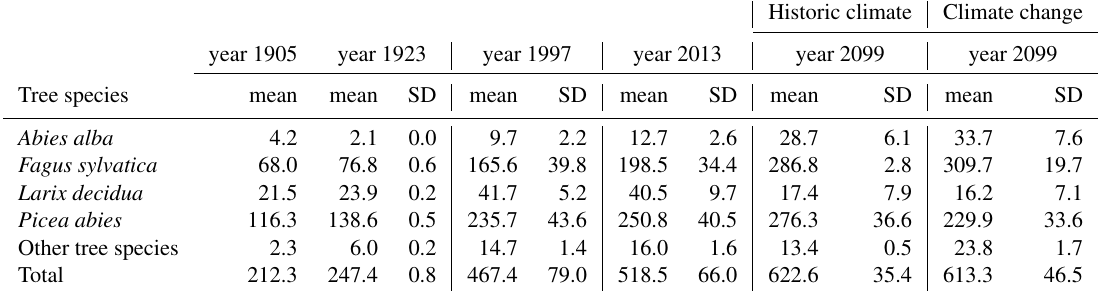
Table 2. Growing stock by tree species (m 3 ha − 1 ). Values are based on iLand simulation runs and indicate species means and standard deviation (SD) over averaged landscape values of the replicates in the respective scenarios. “Historic climate” assumes the continuation of the climate 1950–2010 throughout the 21st century, while “Climate change” summarizes the effect of three alternative climate change scenarios for the 21st